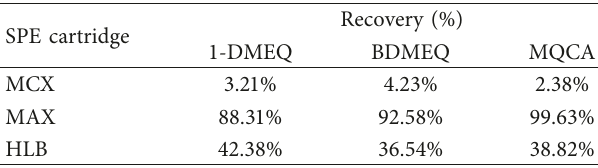
Table 1: MS/MS parameters for MQCA, 1-DMEQ, and BDMEQ in the positive electrospray ionization mode.